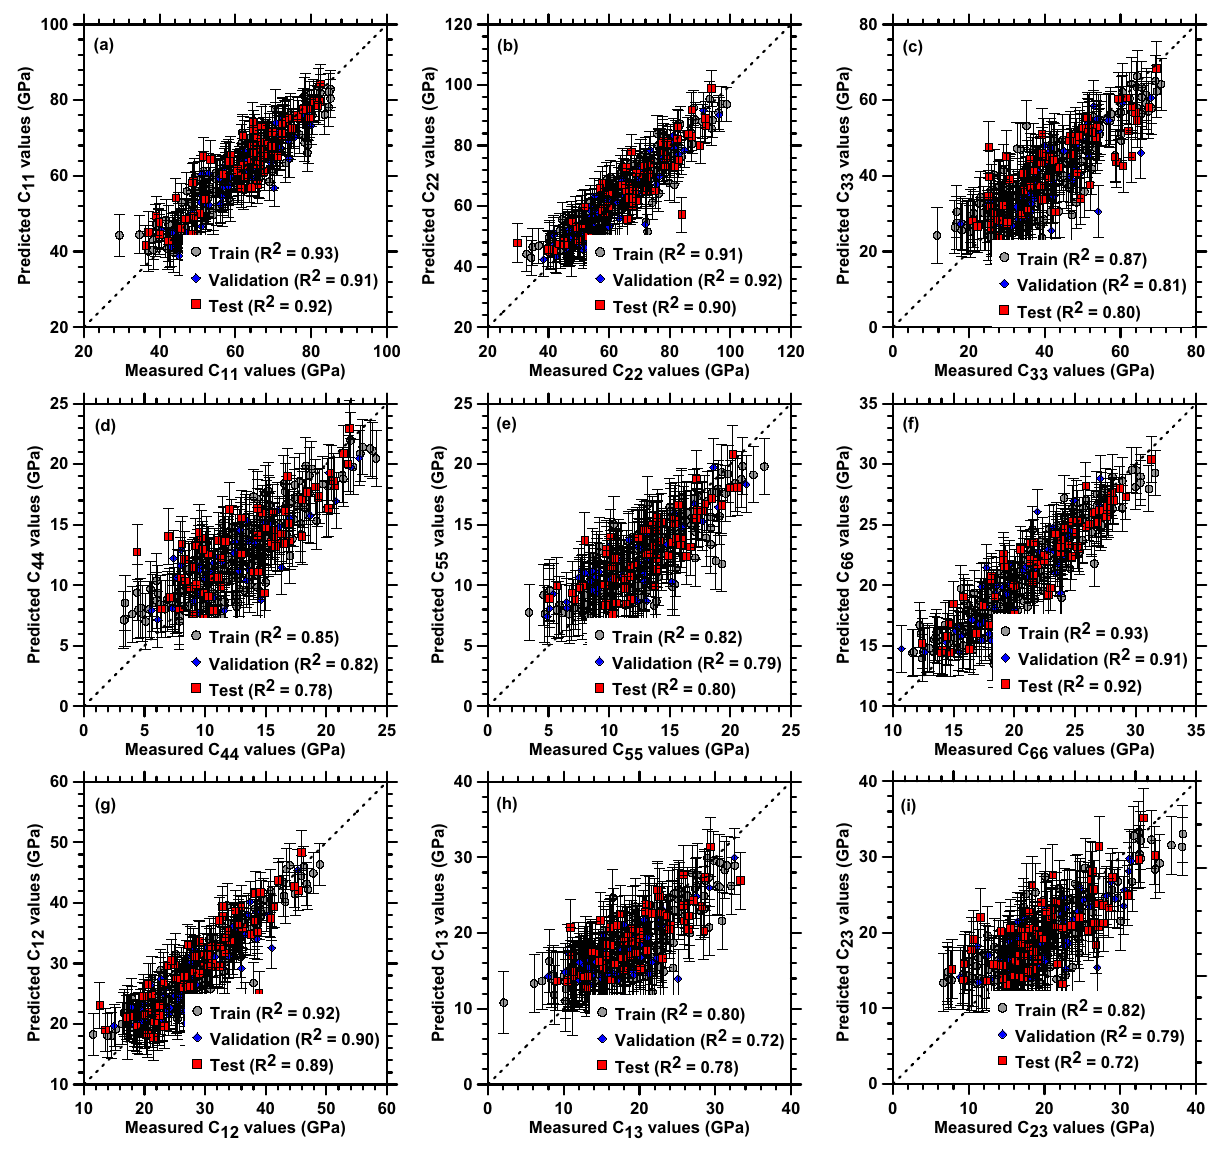
Figure 5. Comparison of the predicted elastic constants by GPR (with RBF kernel) and measured values which are computed by MD simulation. The error bars shown for each value represent the standard deviation around the mean